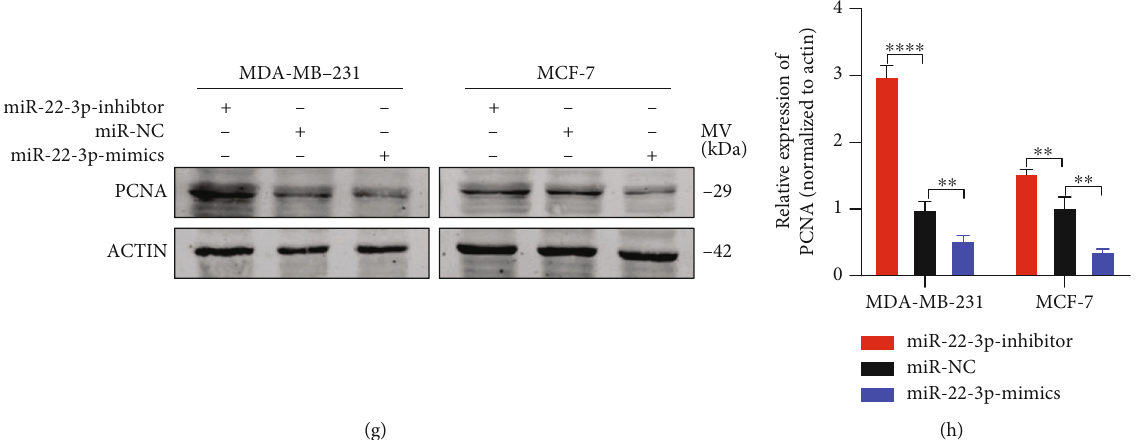
Figure 2: miR-22-3p suppressed cell proliferation of BC cells. (a, b) Expression of miR-22-3p was con fi rmed by RT-qPCR in MDA-MB-231 and MCF-7 cells. (c, d) E ff ect of miR-22-3p on proliferation in MDA-MB-231 and MCF-7 cells by MTT assay. (e, f) E ff ect of miR-22-3p on proliferation in MDA-MB-231 and MCF-7 cells by colony formation assay. (g, h) E ff ect of miR-22-3p on proliferation in MDA-MB-231 and MCF-7 cells by western blotting. ∗∗ p < 0 : 01 ; ∗∗∗ p < 0 : 001 ; ∗∗∗∗ p < 0 : 0001